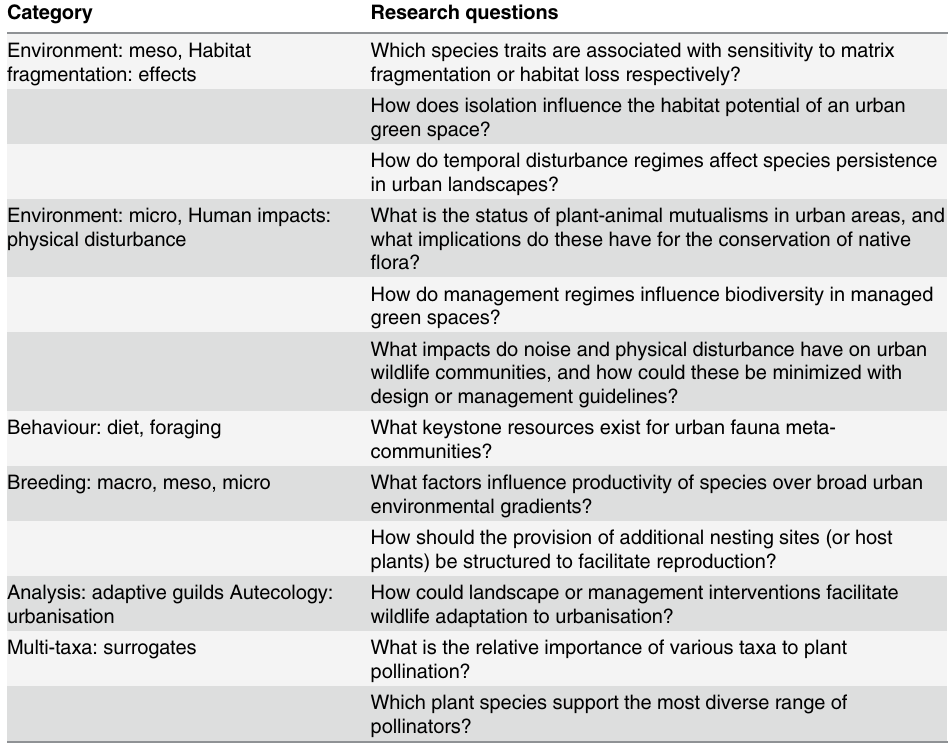
Table 6. Summary of research questions of potential value towards improving CS contributions to UE. Category Research